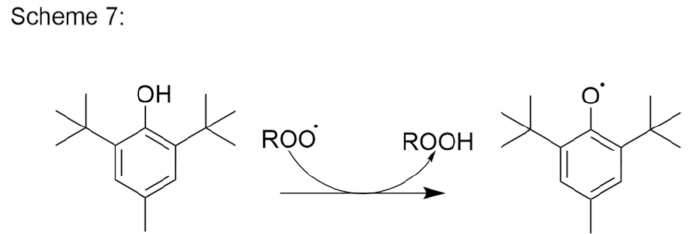
Figure 10. Butylhydroxytoluene reaction with the peroxy radical and stabilization of the radical electron.